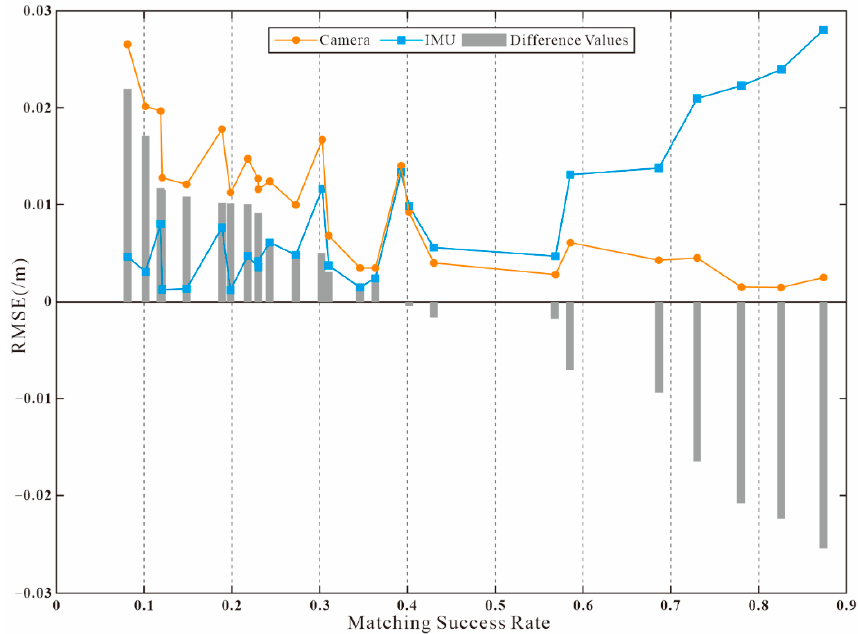
Figure 6. The relationship between the matching success rate and the pose error.